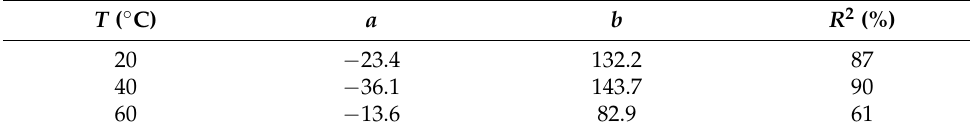
Table 2. Determined values of a and b (G1).